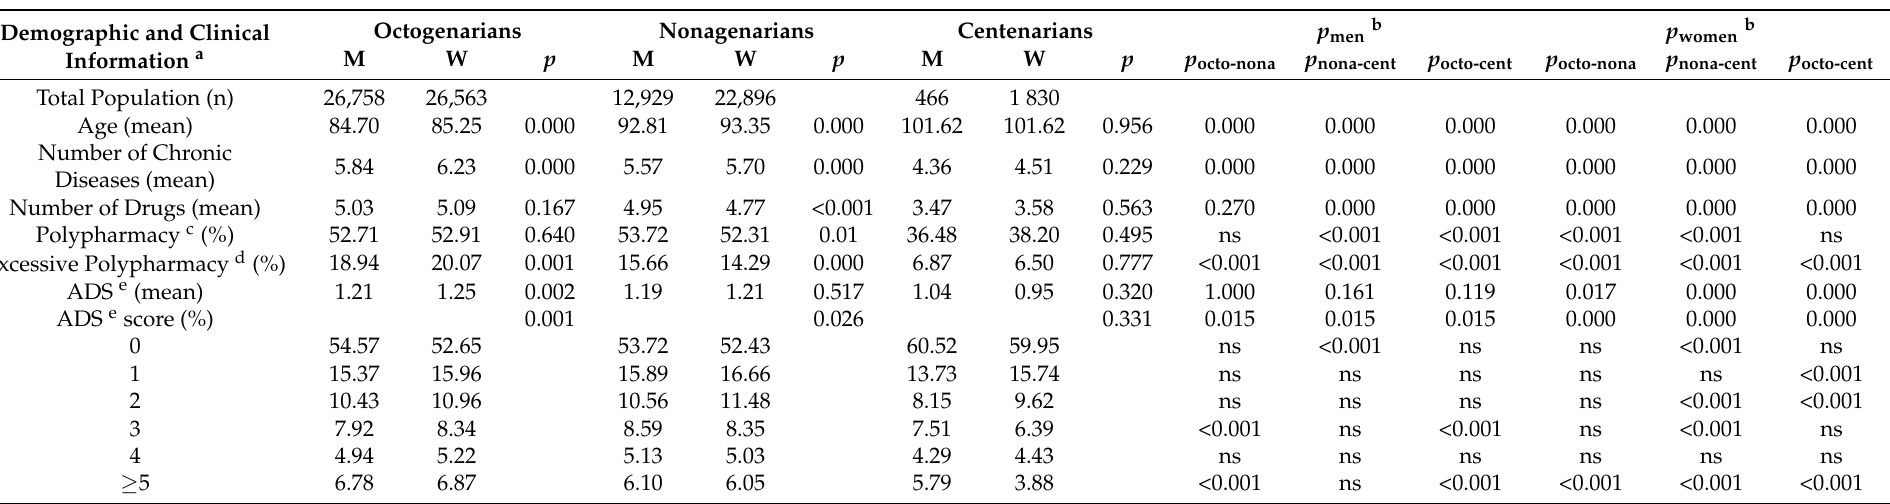
Table 1. Demographic and clinical characteristics of the study population by age group (dead at the age of 80–89, octogenarians; 90–99, nonagenarians; or ≥ 100 years, centenarians) and sex (M, men; W,